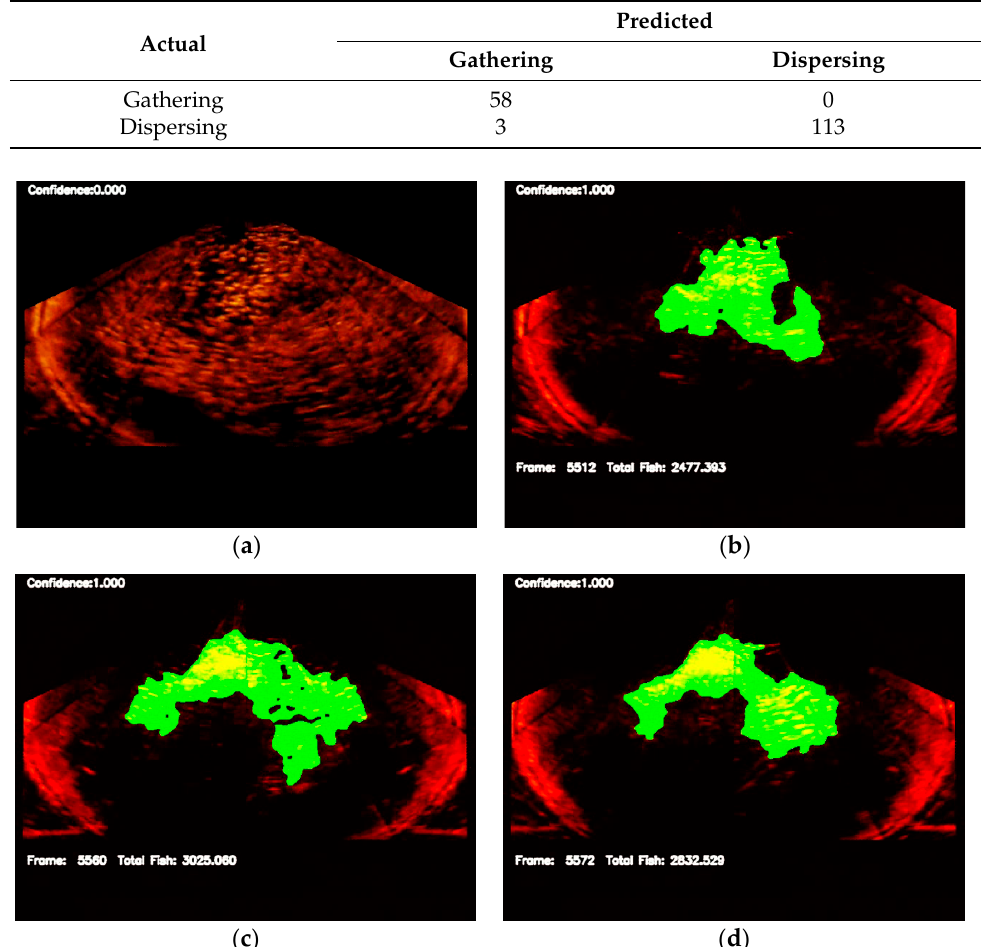
Figure 24. Experimental results of estimating fish quantity where ( a ) shows the non-gathering characteristics of the fish school; and ( b – d ) show the gathering feature of the fish school and the estimated fish quantity based on the fish region identified by the semantic segmentation network.